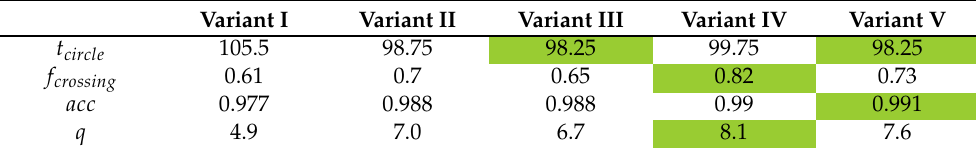
Table 2. Values of performance metrics obtained for five variants of (cid:101) χ updating; simulation scenario Cloud 1 .